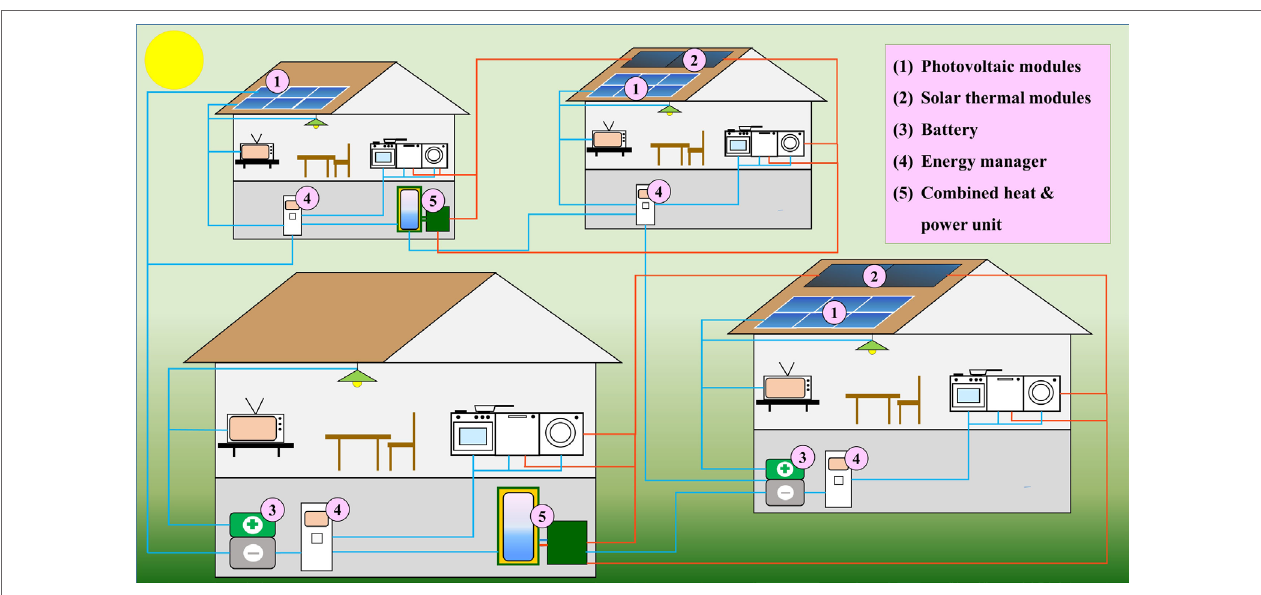
FigUre 3 | Neighborhood Scenario: energy autarky on the neighborhood level.